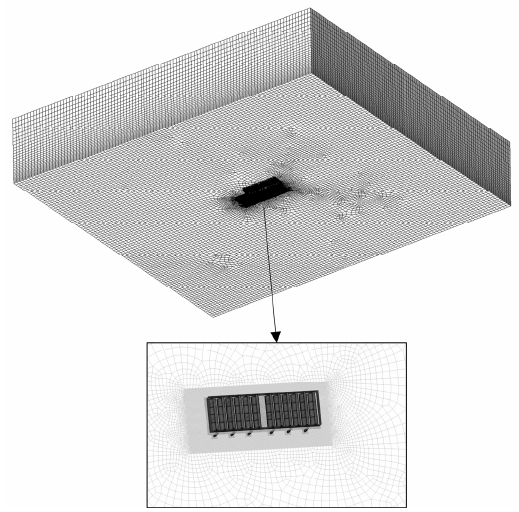
Figure 5. Grid configuration of DACC. Energies 2020 , 13 , x FOR PEER REVIEW